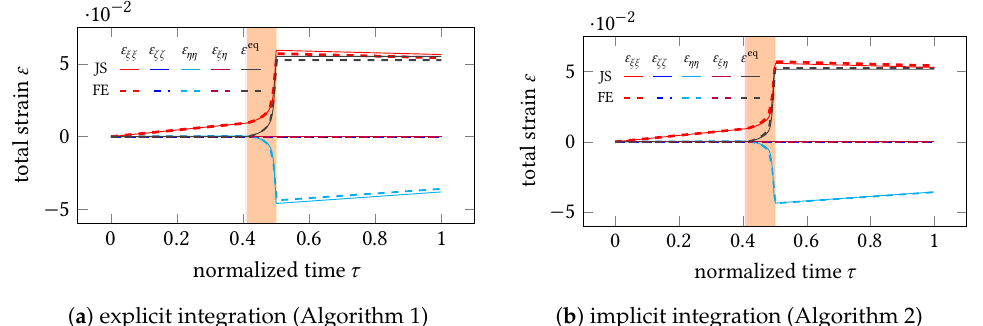
Figure 8. Total and equivalent plastic strain obtained by the FE analysis vs. the results from either the explicit or implicit JS implementation for the loading cycle seen in Figure